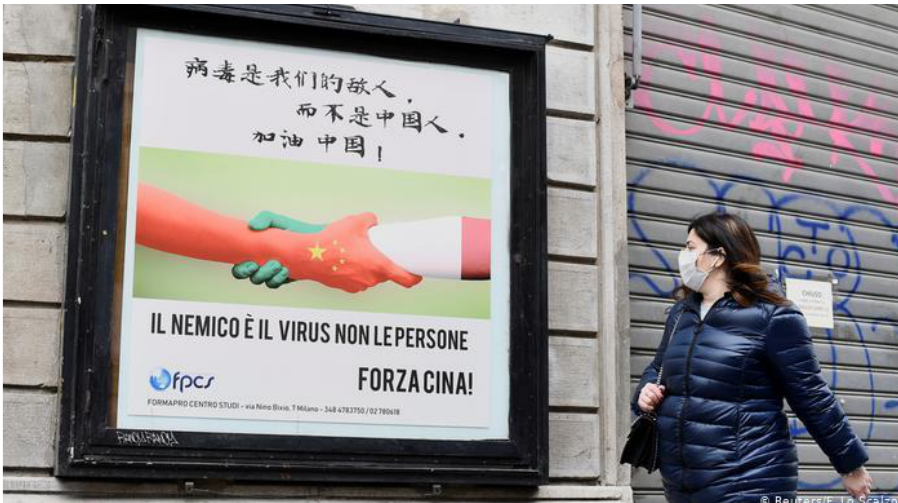
Figure 1. A campaign in Milan’s Chinatown neighborhood, in March 2020, showing Italian and Chinese “helping hands” supporting each other. The text reads: The enemy is the virus, not the